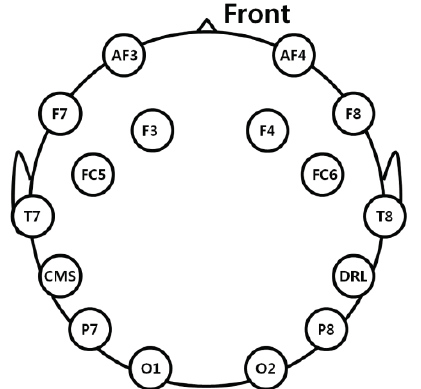
Figure 3. International 10–20 electrode placement